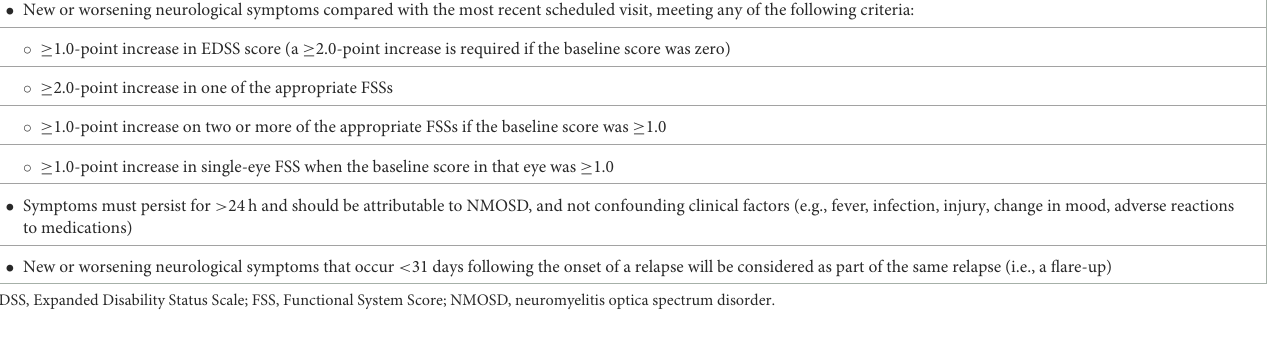
TABLE 2 MRI assessments in